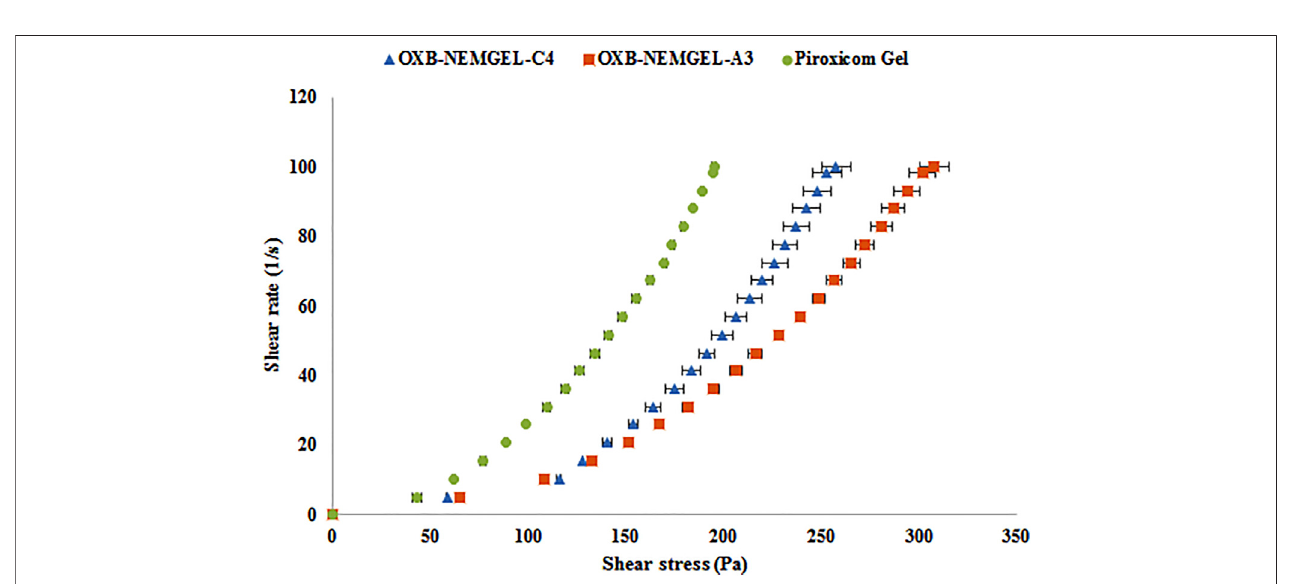
FIGURE 4 | Shear stress vs. shear rate rheogram of CMC-EMGEL and ALG-EMGEL in comparison with piroxicam gel ( n = 3).